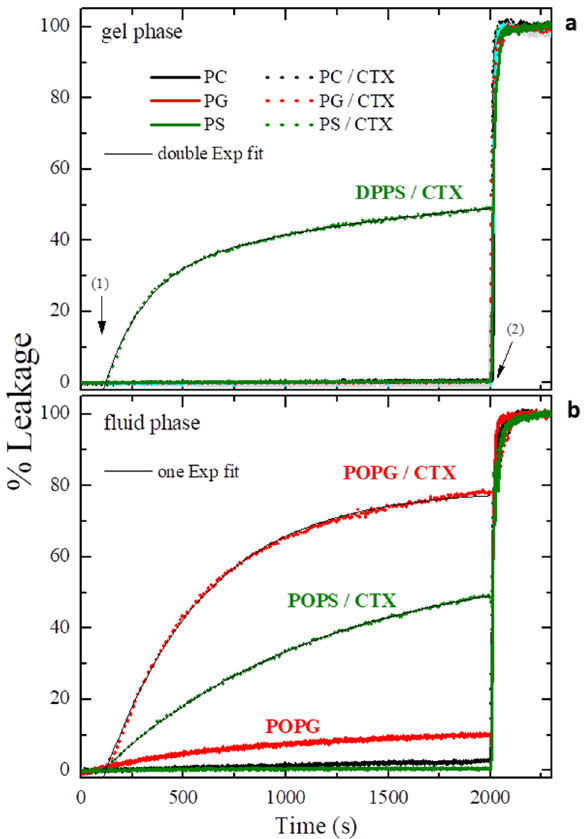
Figure 3. Kinetics of carboxyfluorescein (CF) leakage through LUVs composed of 100 µM of DPPC, DPPG and DPPS, in the gel phase, and POPC, POPG and POPS in the fluid phase, in absence and presence of 0.1 mol% of CTX relative to the lipid concentration (see Eq. (2) in MM section). All experiments were performed at 25 °C. Arrow (1) indicates the moment the protein was injected, and arrow (2) the moment of surfactant was added. Black thin solid lines represent the best fittings using Eq.